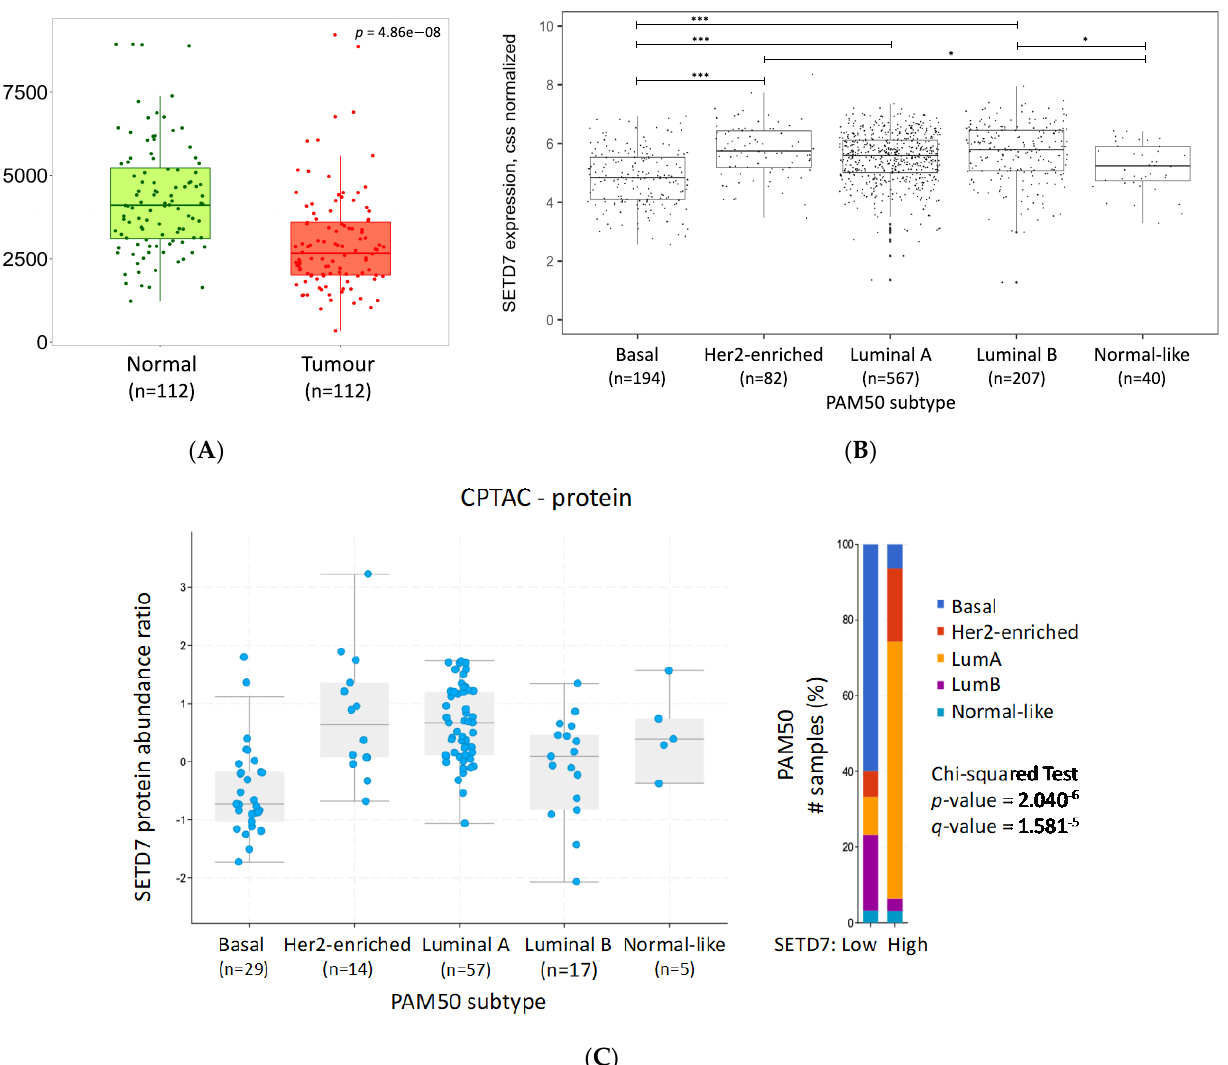
Figure 1. SETD7 expression in breast cancer. ( A ) SETD7 mRNA expression in tumour and adjacent normal tissue using RNA-seq data available from TNMplot; ( B ) SETD7 mRNA expression across PAM50 subtypes using TCGA-BRCA data in R. ANOVA followed by Tukey’s test: * < 0.05; **** < 0.0001 ( C ) SETD7 protein expression across PAM50 subtypes using CPTAC data from cBioPortal.